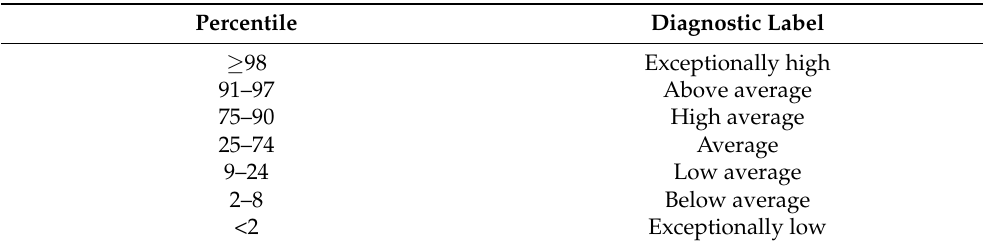
Table 3. Consensus criteria for converting percentiles to diagnostically meaningful labels (based on